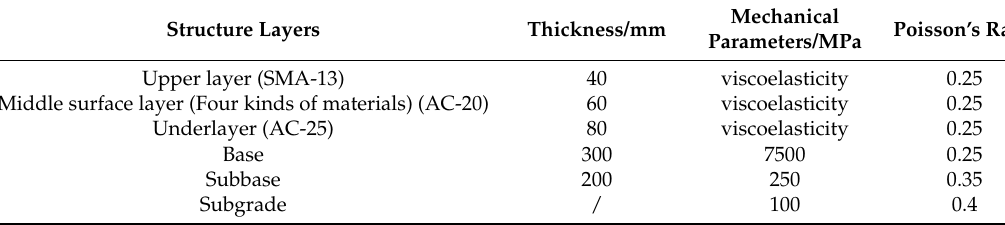
Figure 4. 3D pavement finite element model (FEM): ( a ) FEM; ( b ) mesh part. Table 10. Parameters for pavement structure layers.